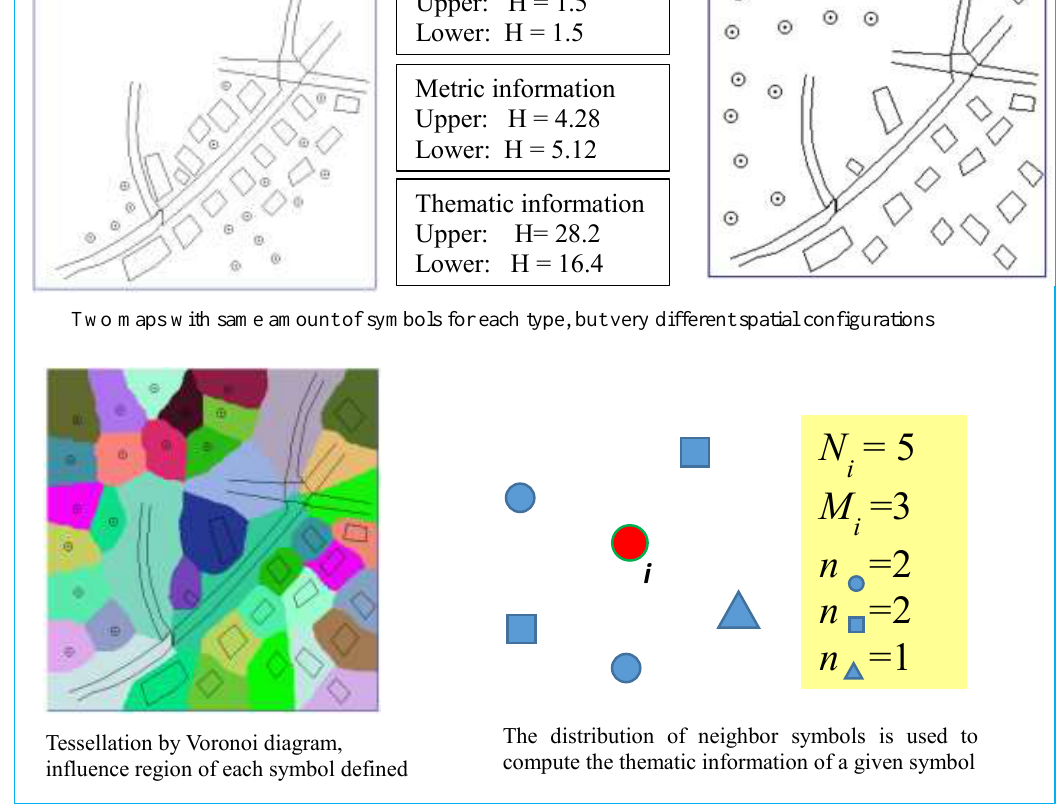
Fig. 4 Two maps with very different spatial configurations (modified from Knopfli 1983, and Li and Huang 2002), thus with very different configurational information, but identical Shannon entropy